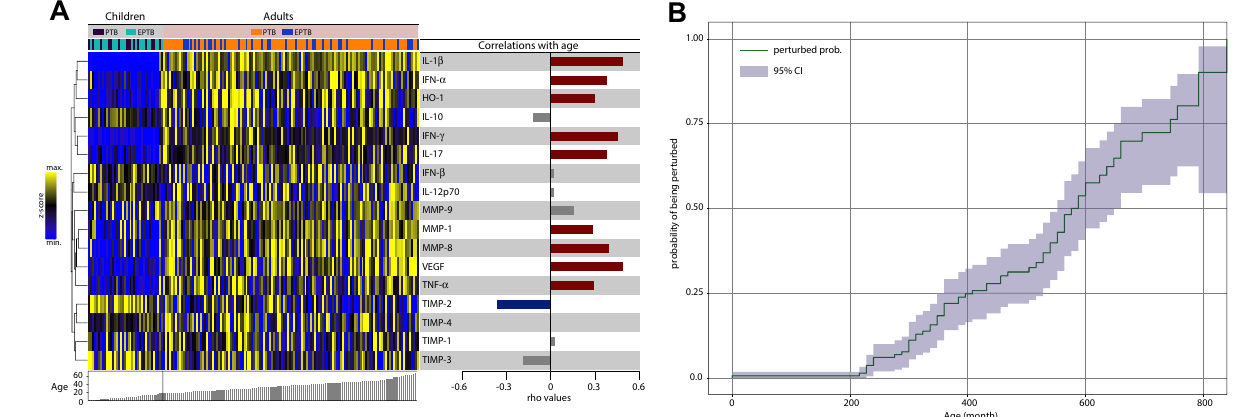
Figure 4. Associations between molecular degree inflammatory perturbation and age in TB patients. ( A ) Molecular degree of perturbation was assessed in samples from adults and children with tuberculosis. Data were z-score normalized. A hierarchical cluster analysis was employed to group the biomarkers based on their overall expression profile in the study population. Dendrograms represent Euclidean distance. Each individual was grouped based on age. The right panel shows Spearman correlation coefficient values of relationships between the indicated parameters and age. ( B ) The Kaplan–Meier curve shows the probability of being molecularly perturbed according to the age. Spearman correlation rank was compared used Steger Method.